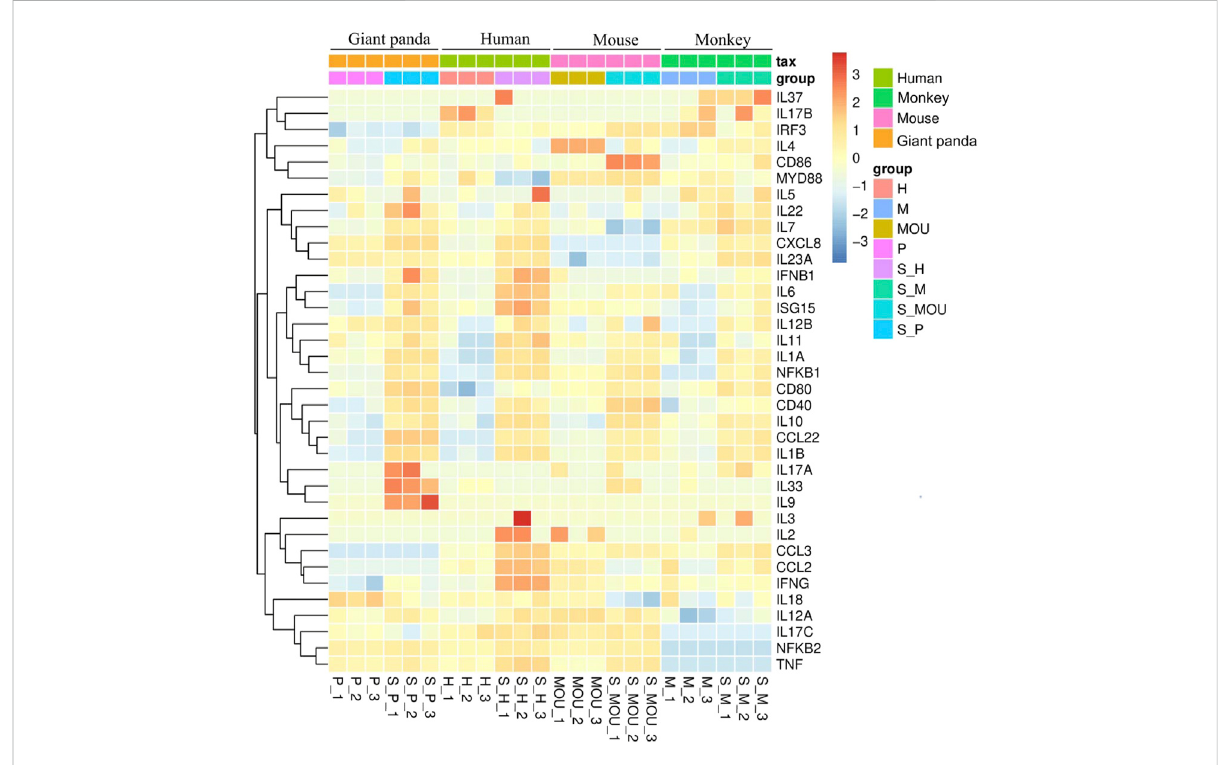
FIGURE 6 Heat map of representative gene expression across all samples from the four